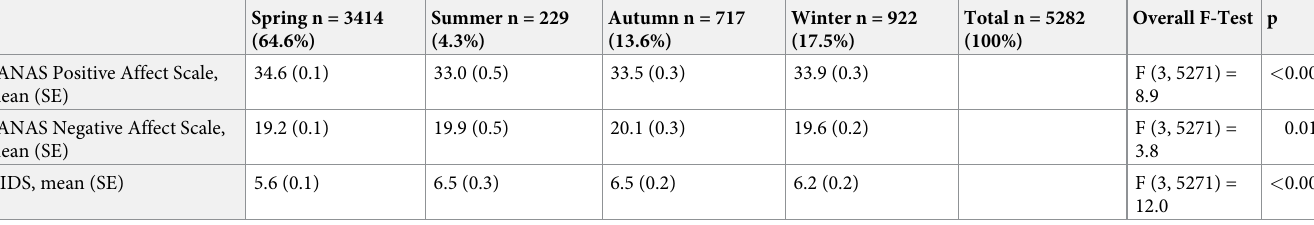
Table 3. Seasonal distribution of positive affect, negative affect and depressive